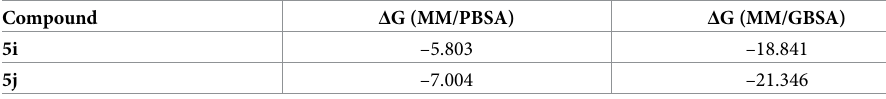
Table 6. MM/PBSA and MM/GBSA calculations for compounds 5i and 5j. Compound